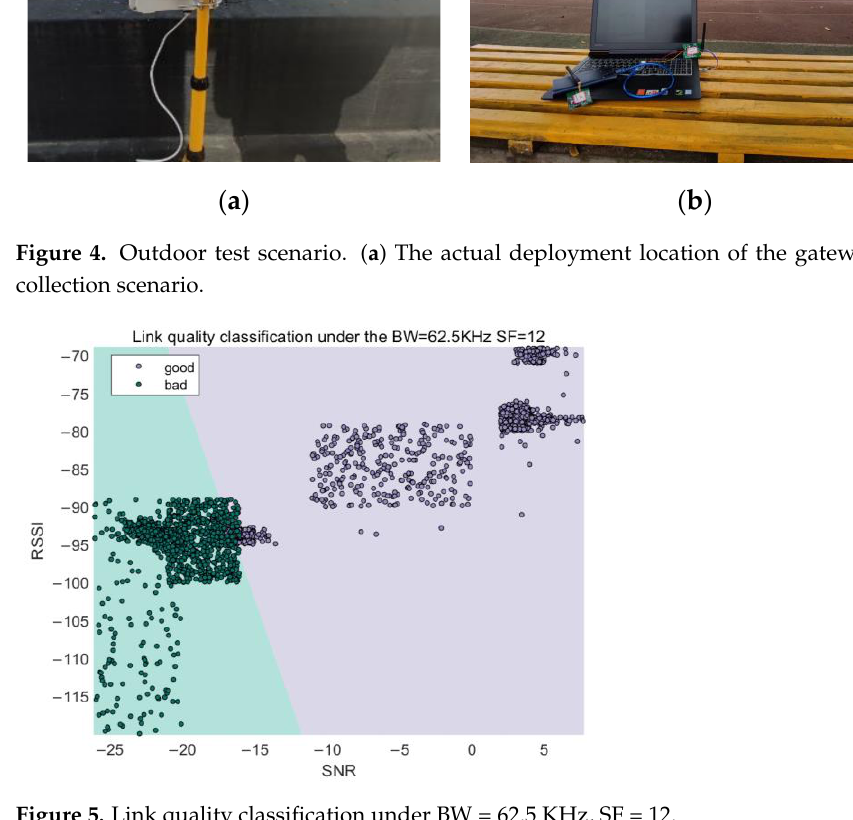
Figure 5. Link quality classification under BW = 62.5 KHz, SF = 12.